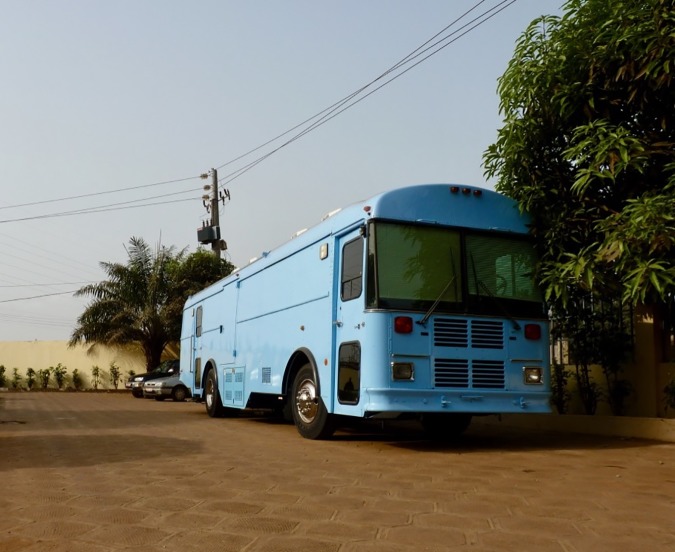
The Plasma mobile.